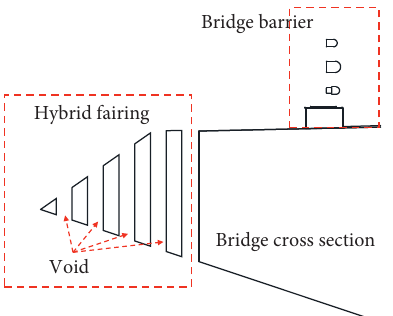
Figure 1: Concept of the proposed new-type hybrid